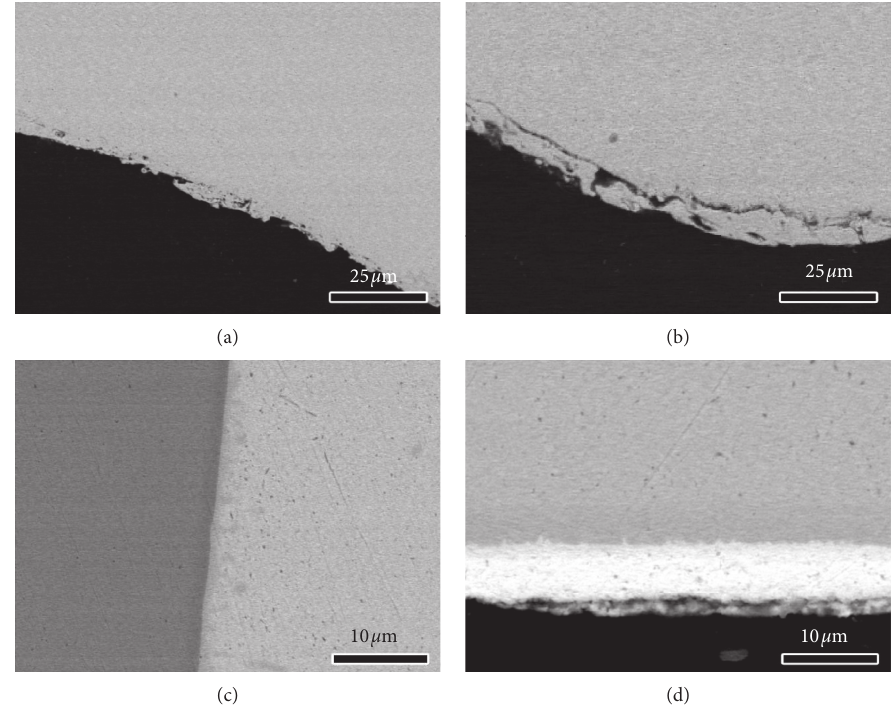
Figure 12: Cross-sectional SEM micrograph of the weld of antishock MOS tube: Pin 1 (a), Pin 2 (b), Pin 3 (c), and resistor tube (d).